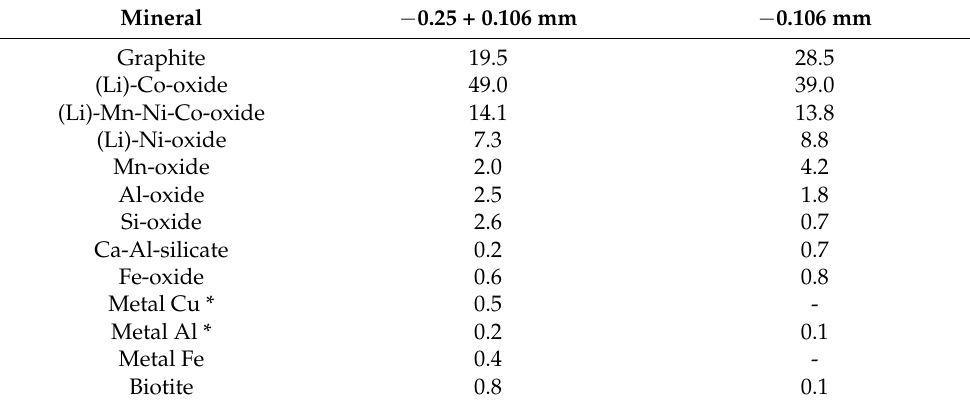
Table 1. The contents of the Li-containing metal oxides and graphite in the fractions of − 0.25 + 0.106 mm and − 0.106 mm (wt.%).